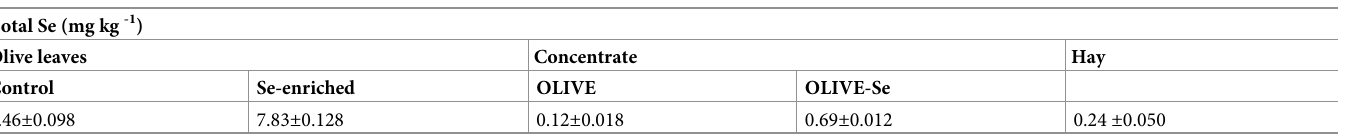
Table 1. Total Se contained in feeds.